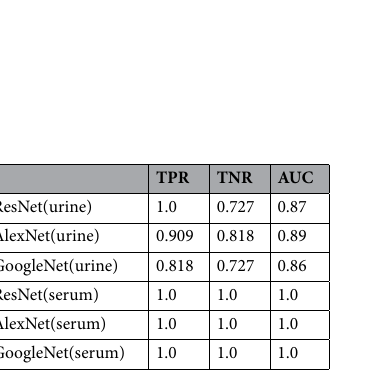
Table 3. Neural network model sensitivity, specificity and